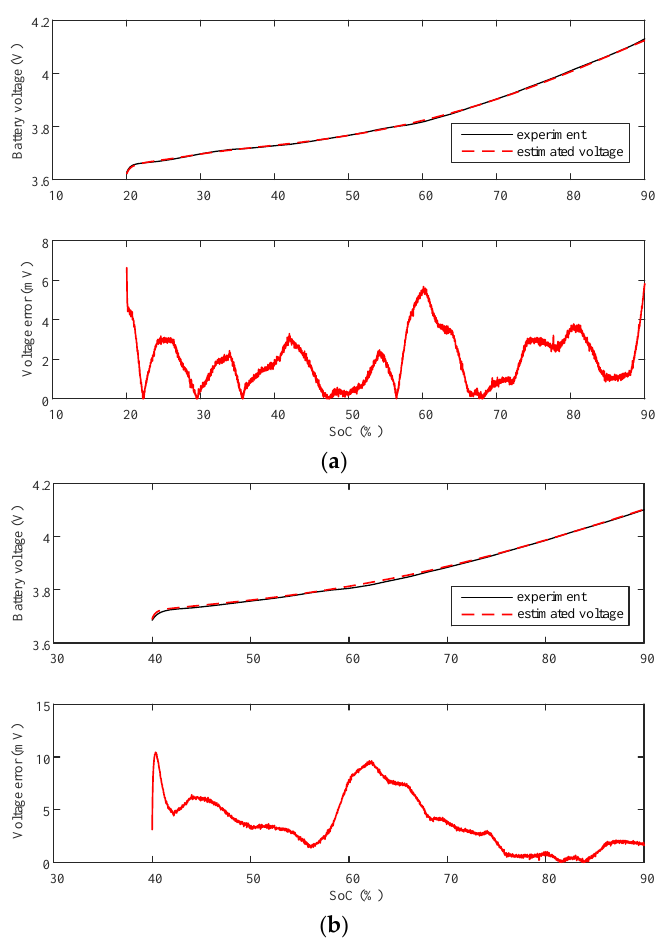
Figure 14. CC charging voltage profiles at different initial SoC : ( a ) initial SoC = 20%; ( b ) initial SoC = 40%.